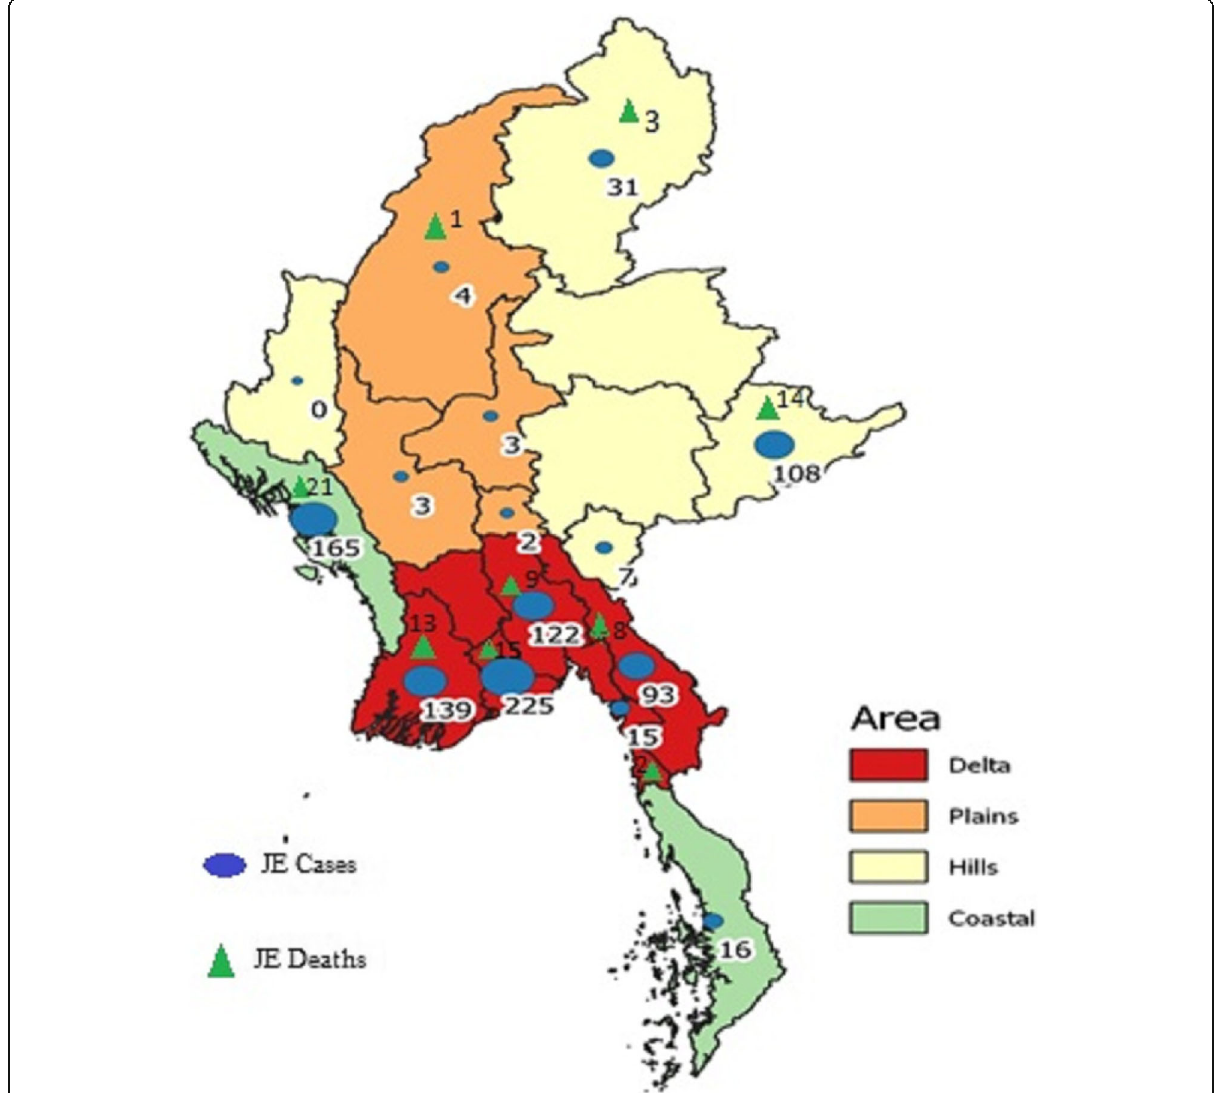
Fig. 3 Distribution of all hospital-reported JE cases and deaths in Myanmar between 2012 and